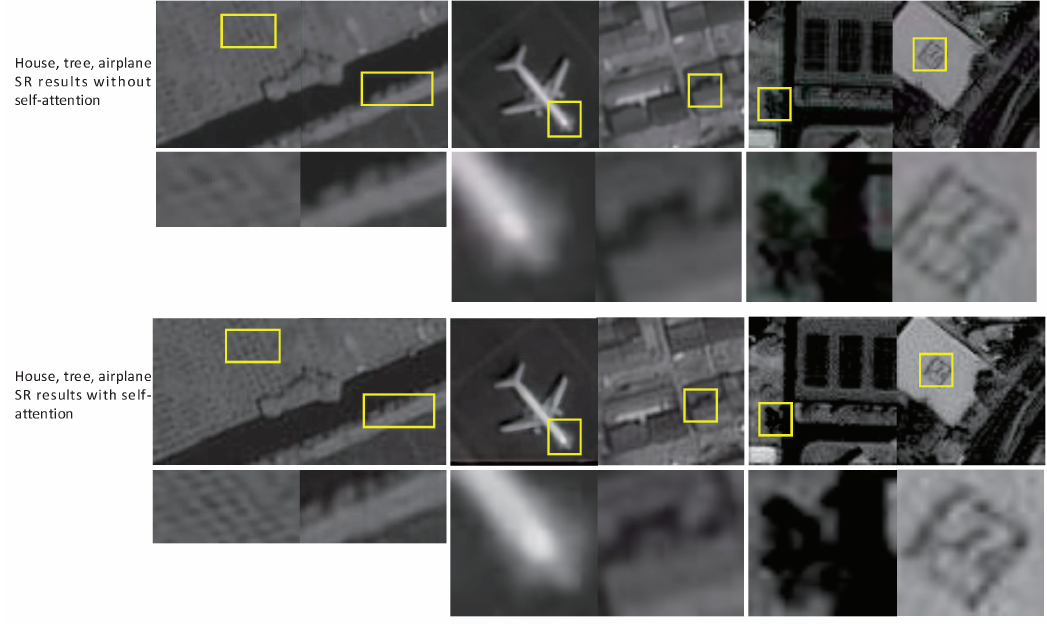
Figure 6. Panchromatic (PAN) image super-resolution (SR) from